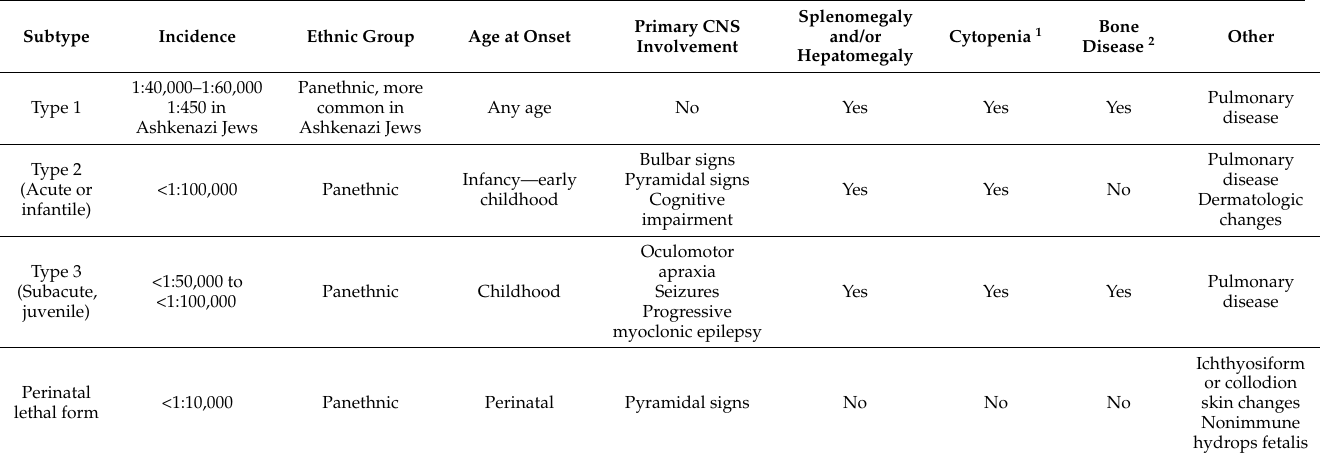
Table 1. Clinical subtypes of Gaucher